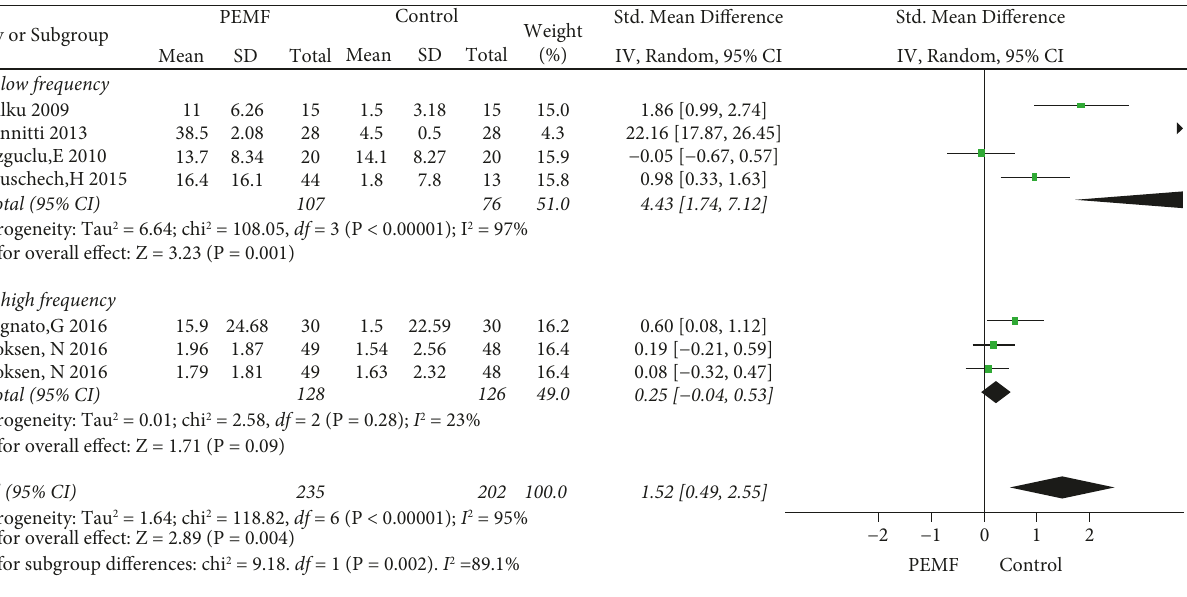
Figure 9: Forest plots represent the effect of PEMF versus control therapies in physical function and subgroup analysis basing on various frequency.